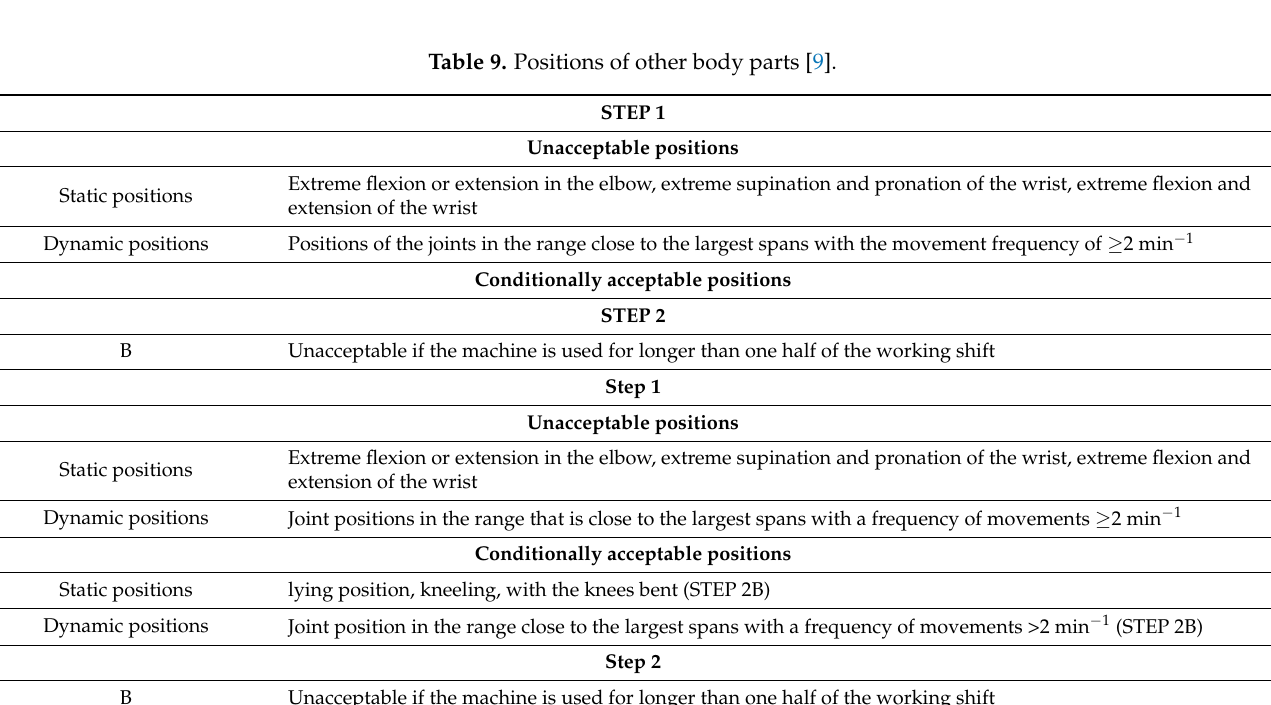
Table 9. Positions of other body parts